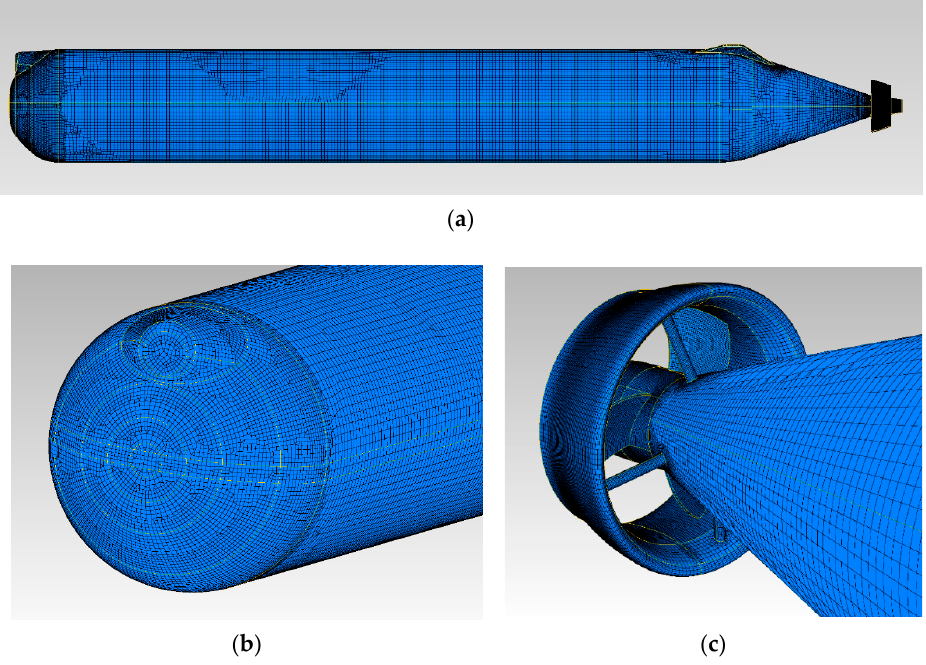
Figure 7. Surface grids generated based on the CAD model of SST hull: ( a ) side view, ( b ) zoom in at the front region, and ( c ) zoom in at the back region.